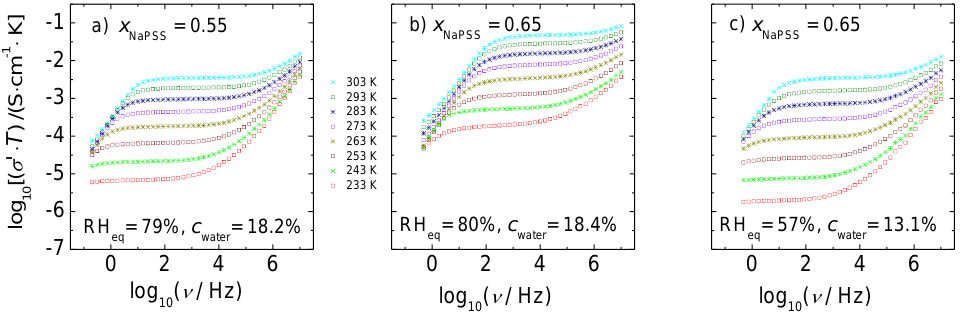
Figure 5. Temperature-dependent conductivity spectra of x NaPSS∙(1 − x ) PDADMAC obtained by conductivity spectroscopy. ( a ) x NaPSS = 0.55, RH eq = 79%; ( b ) x NaPSS = 0.65, RH eq = 80%, and ( c ) x NaPSS = 0.65, RH eq = 57%. The different isotherms were taken at fixed water content as specified in the figures.